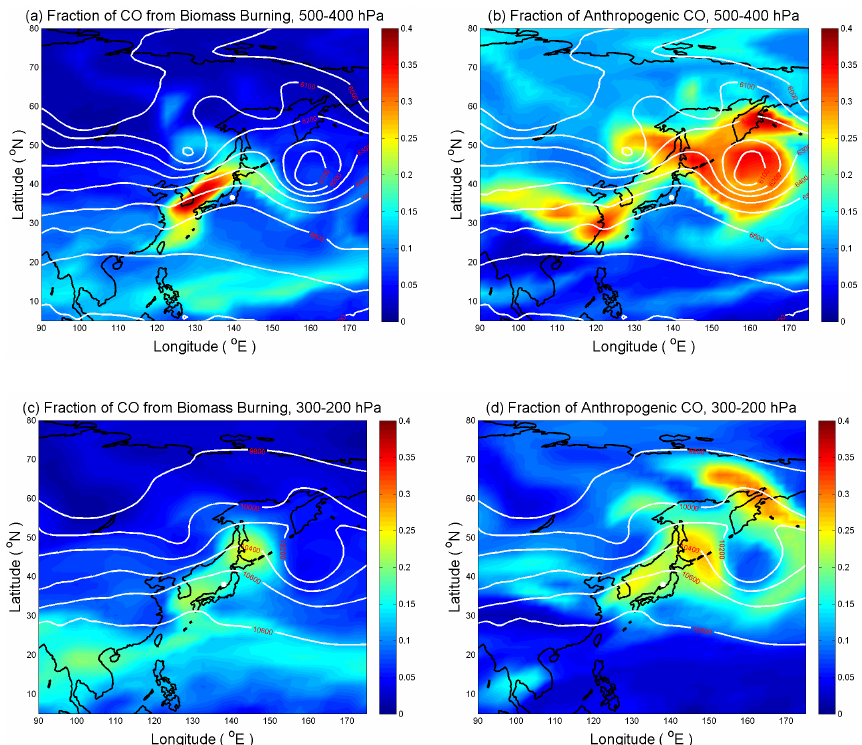
Figure 15. The GEOS-Chem simulated fractional CO (a) from biomass burning and (b) from the anthropogenic source on 10 April 2005 at 00:00 UTC in the middle troposphere (500–400hPa). (c) and (d) are the same as for (a) and (b) , respectively, but in the upper troposphere (300–200hPa). The geopotential height at 450 and 250hPa is overlaid with the CO images in the middle and upper troposphere, respectively. White dots indicate the location of MOZAIC